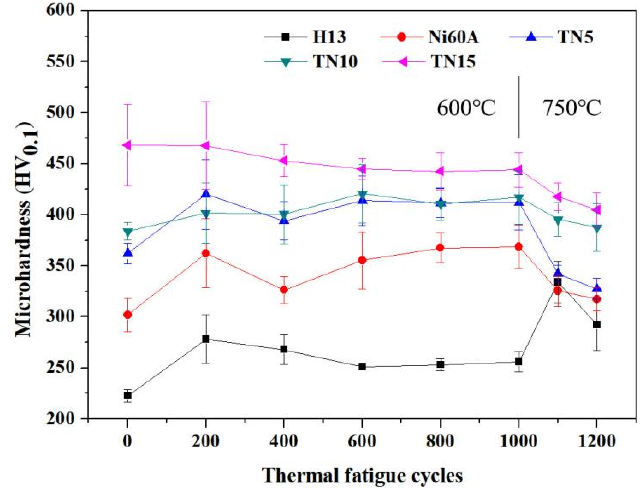
Figure 10. Surface microhardness of different samples during thermal fatigue cycles.